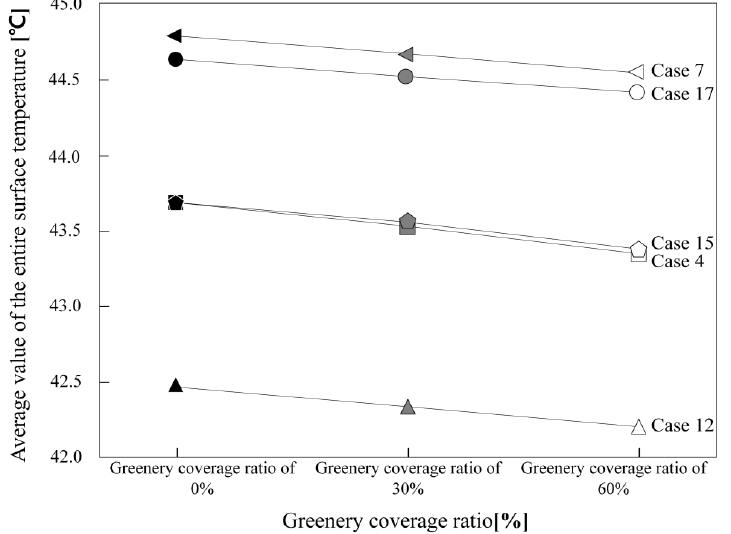
Figure 6. Average value of the entire surface temperature according to the change of the greenery coverage ratio.